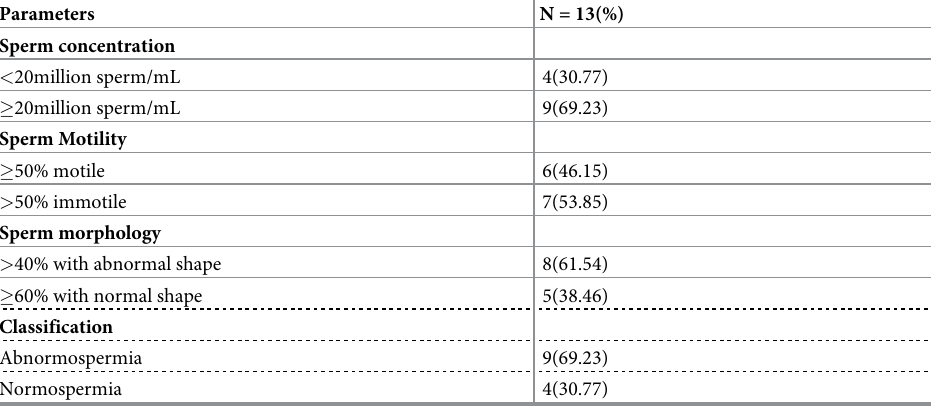
Table 4. Semen parameters and classification of study population with history of